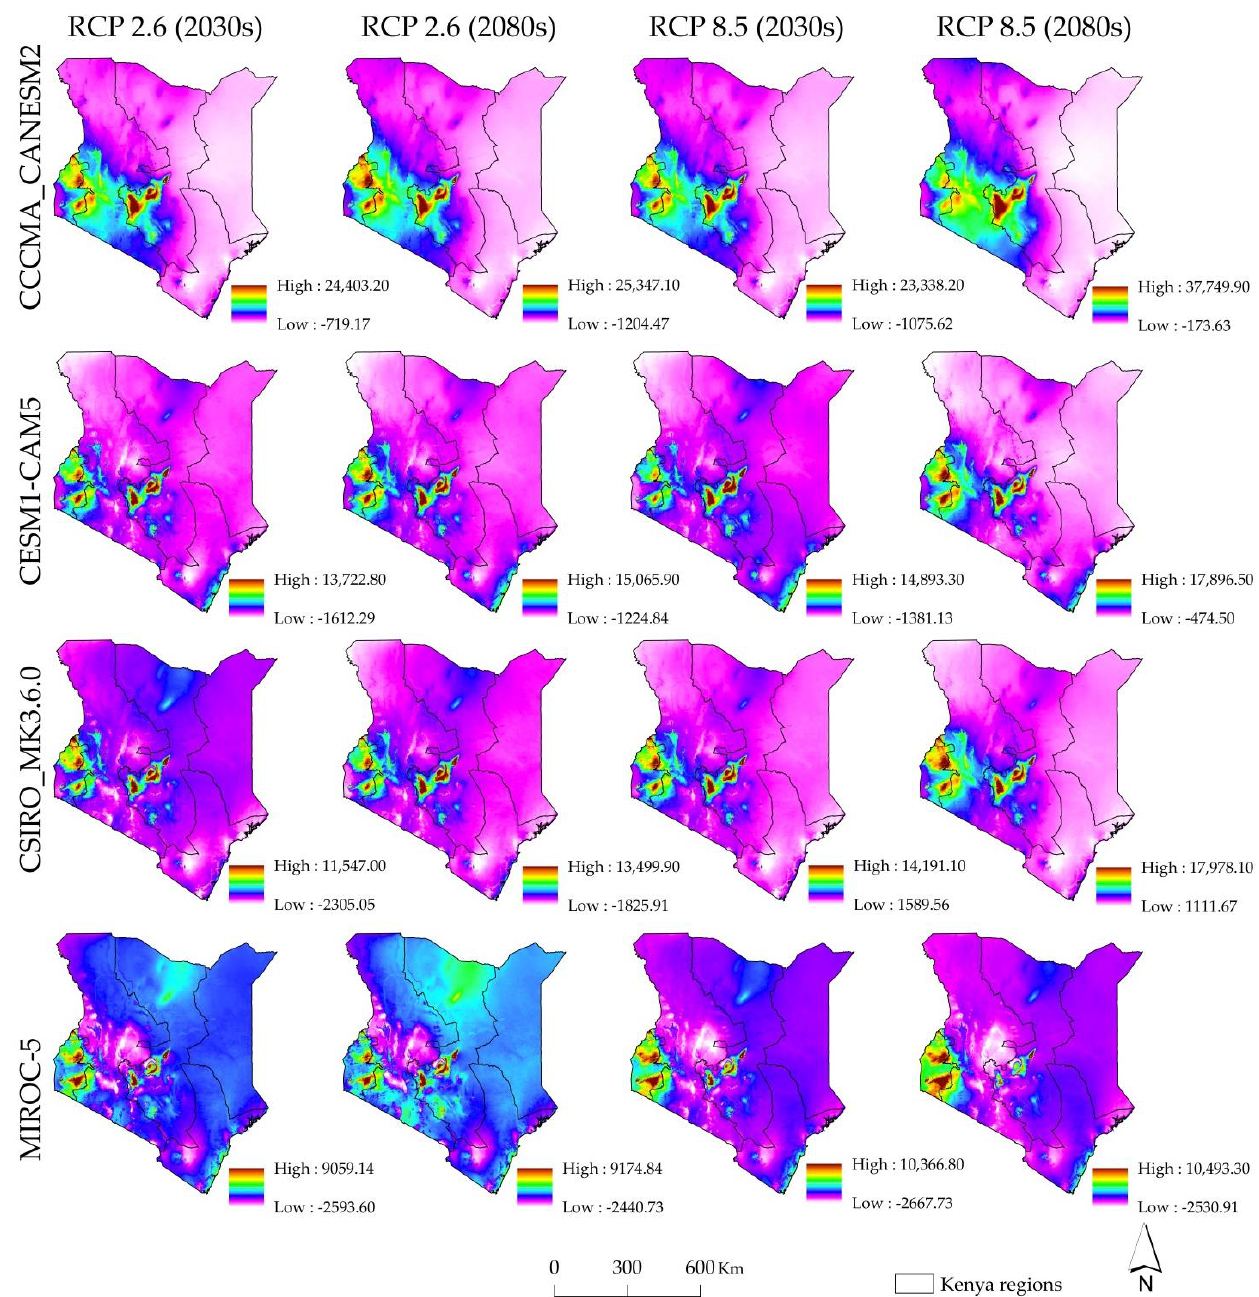
Figure 11. Absolute differences of rainfall erosivity (MJ mm ha − 1 h − 1 yr − 1 ) between the 2030 and 2070 projections and baseline data.